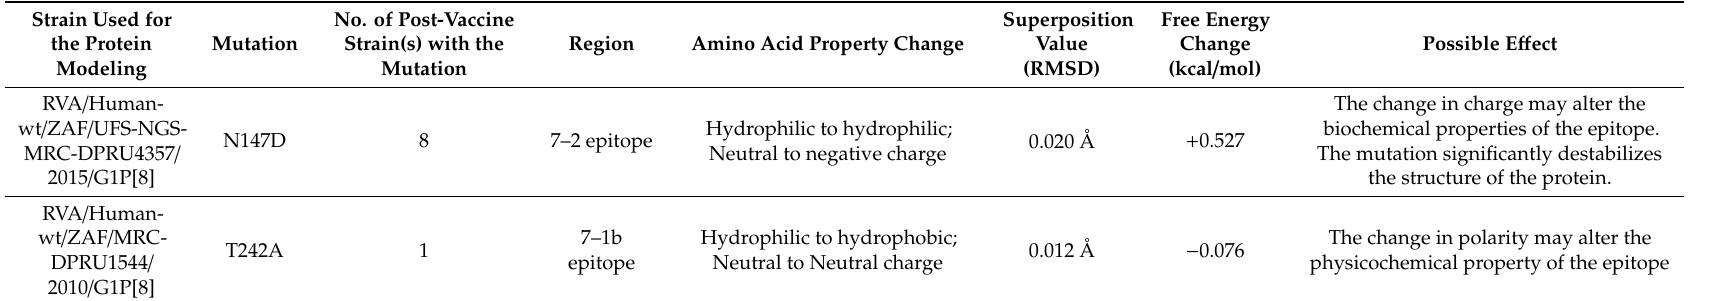
Table 2. Possible e ff ects of amino acid mutations in South African post-vaccine G1 neutralization epitopes.